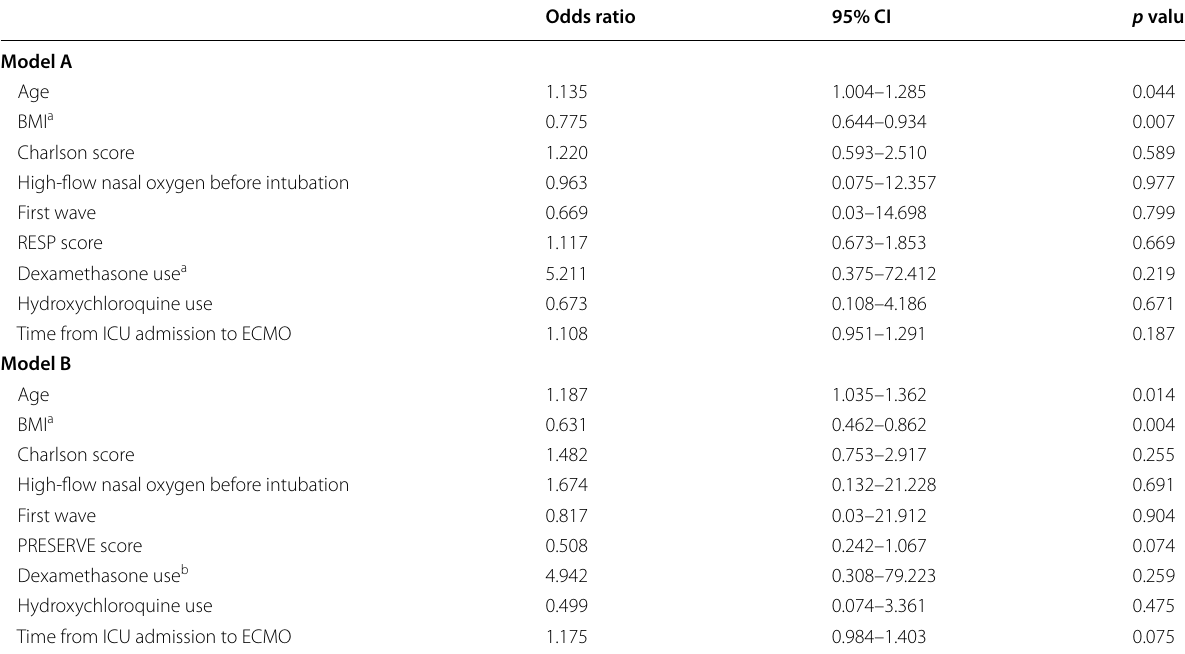
Table 3 Multivariate analysis of predictors of 90‑day